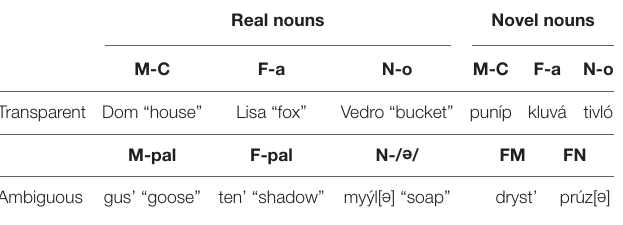
TABLE 1 | Experimental stimuli. Real nouns Novel nouns